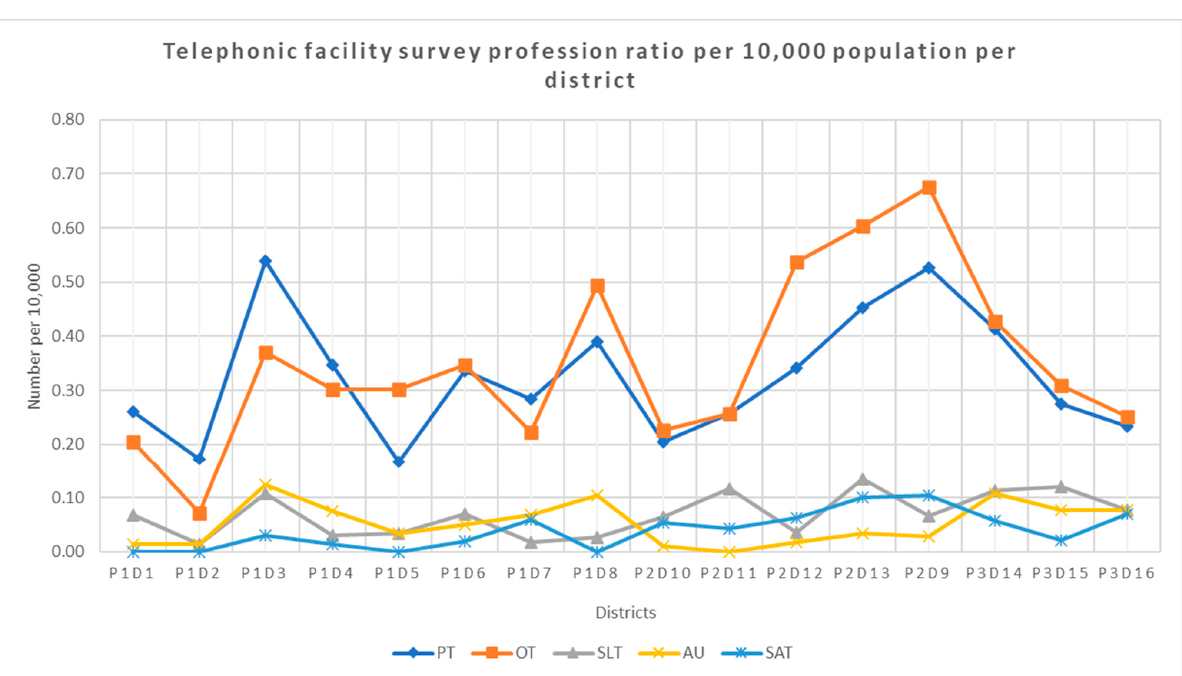
Figure 9. Telephonic facility survey profession distribution per 10,000 population per province. Leg- end: PT—physiotherapy, OT—occupational therapy, SLT—speech–language therapy, AU—audiol- ogy, SAT—speech and audiology therapy and P—province. The highest number of profession type per 10,000 uninsured population per provin- cial district was OT at 0.68 in district nine, while the lowest number of therapists is 0.01 for audiology in district one, two and eight and SLT in district two (see Figure 10).